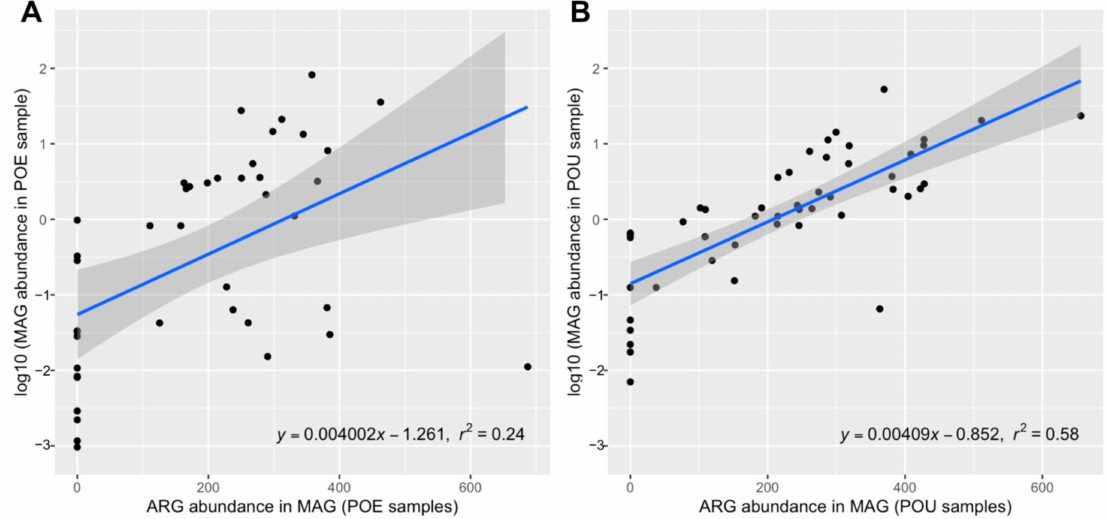
Figure 3. Correlation between genome-resolved ARG relative abundance (mean coverage Q2Q3 per 10 million reads in metagenome-assembled genomes (MAG)) and MAG relative abundance (log 10 of mean Q2Q3 coverage per 10 million reads in water microbiome) in ( A ) POE samples and ( B ) point of use (POU samples). Shade zone indicated correlation within 95% confidence